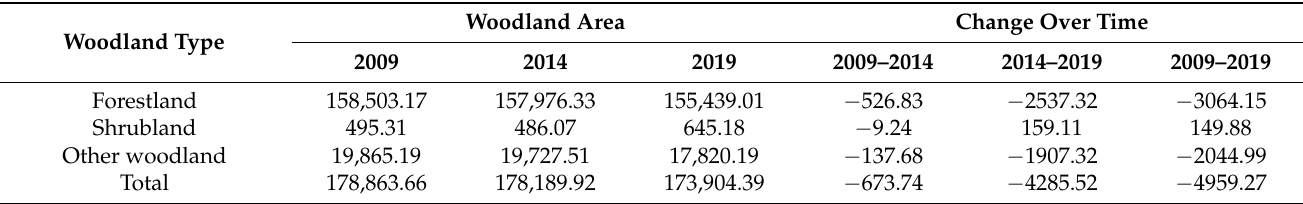
Table 6. Transfer matrix of woodlands in Anyuan County, 2009–2019 (Unit: ha).